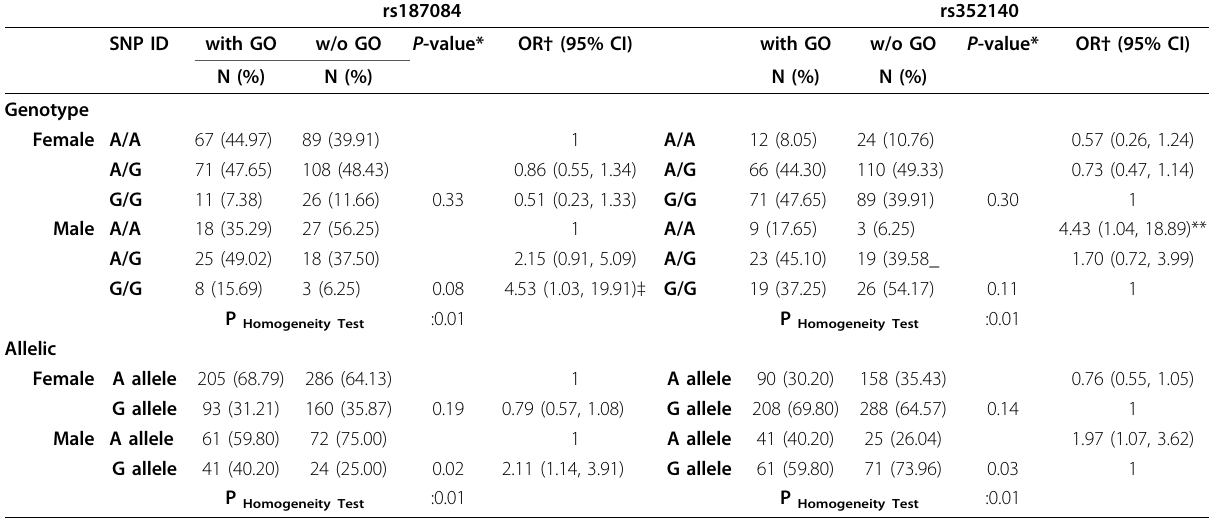
Table 2 The Genotype and Allelic Frequency of TLR-9 Stratified by Sex among Graves ’ Disease Patients in Taiwan